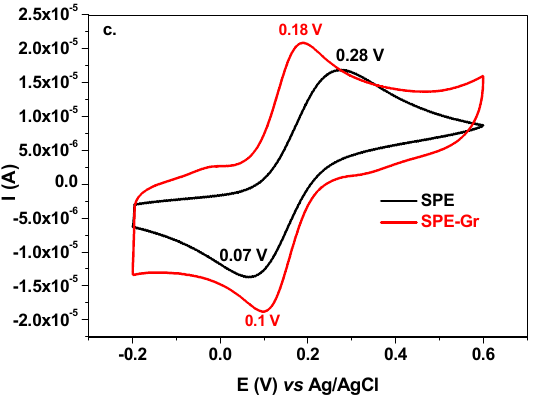
Figure 5. CVs recorded with SPE ( a ) and SPE-Gr ( b ) in the presence of 10 − 3 M K 4 [Fe(CN) 6 ] in 0.2 M KCl supporting electrolyte at various scanning rates, from 2 to 100 mV / s; comparison between two CVs recorded with SPE and SPE-Gr; 50 mV / s scan rate ( c ).